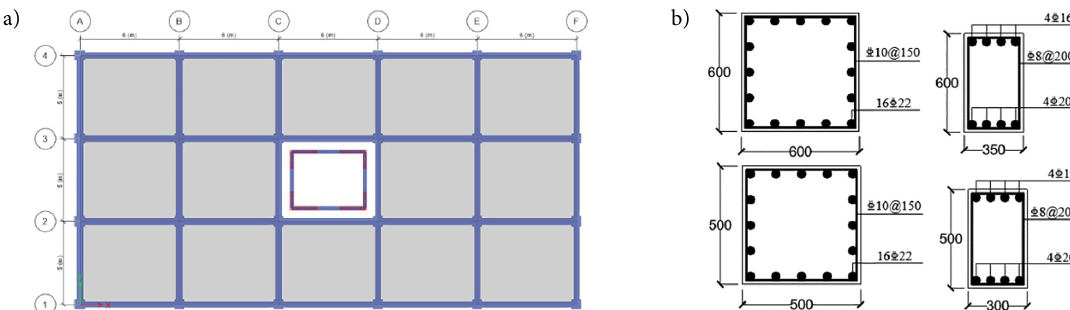
Figure 5. New staggered story isolated structure diagram: a – structural plane diagram; b – structural reinforcement drawing